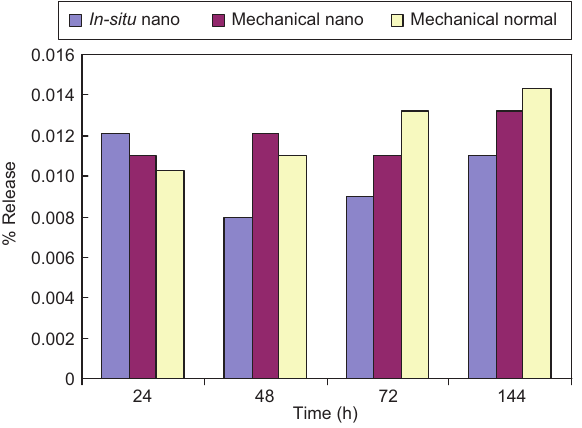
Figure 4 Release profile of emulsions prepared by in situ nano ZnO, mechanical nano ZnO and mechanical normal